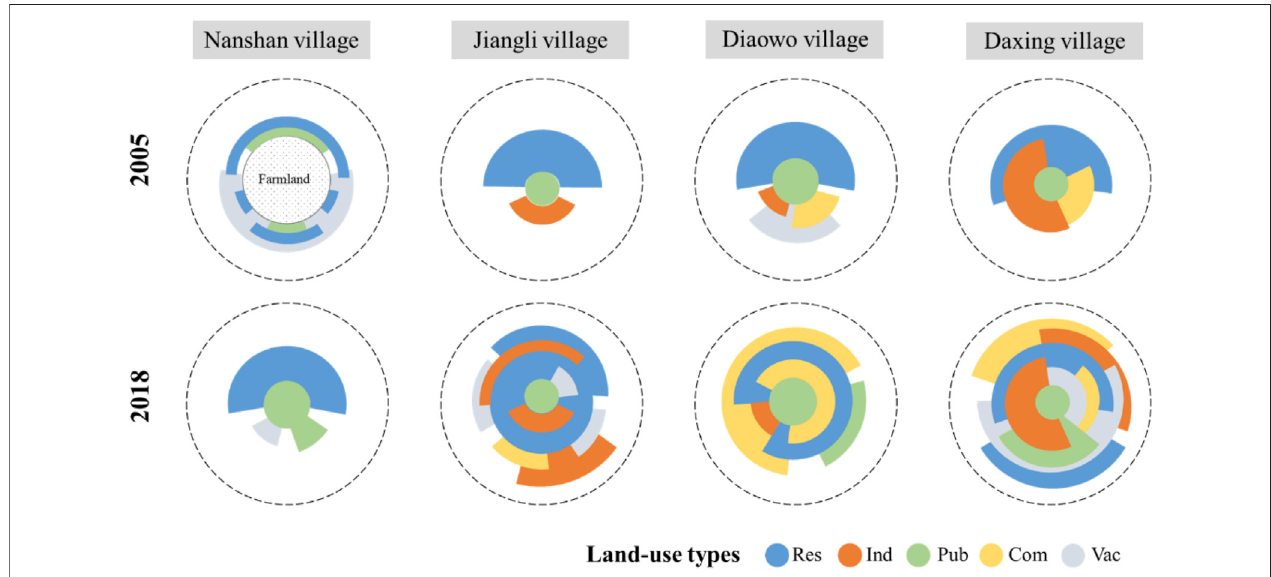
FIGURE 6 | Spatial structure of four typical